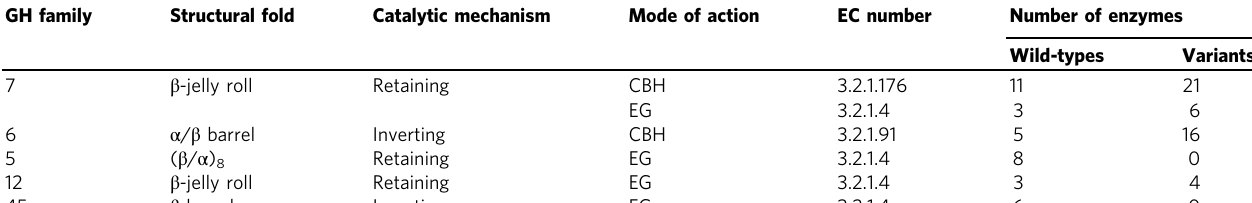
Table 1 Fungal cellulases characterized in this study.